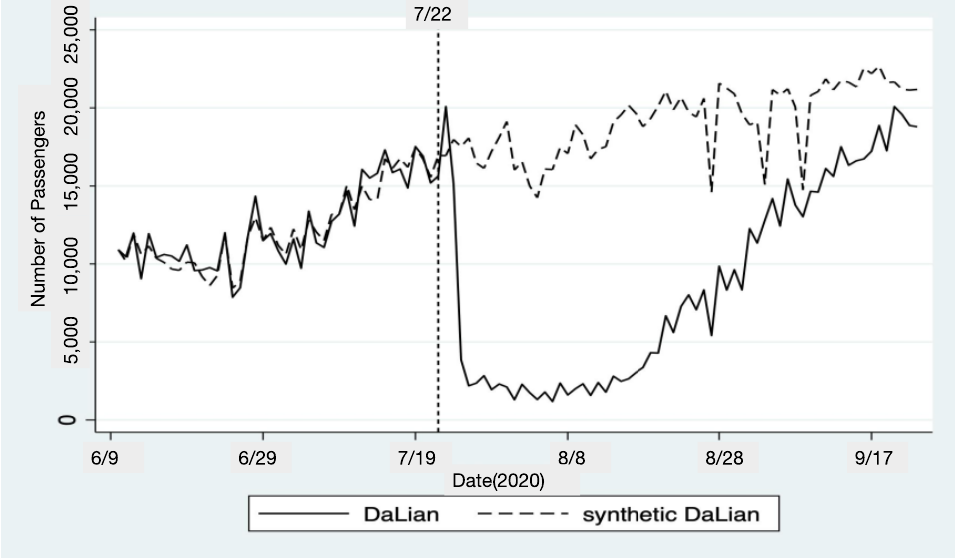
Figure 7. Dalian air passenger changing trend (SCM).